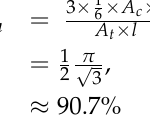
Figure 1. Equilateral triangle to determine the maximum density of a packed wire assembly. The volume of a triangular pillar and a wire are both determined by area of the face, triangle, and circle, respectively, times their length l. The area of an equilateral triangle is √ A t = 1 a 2 3 (with a being the length of the sides) and of a circle A c = π r 2 (with r being the 4 radius). Considering the relation shown in Figure 1, the theoretical achievable density d th is determined